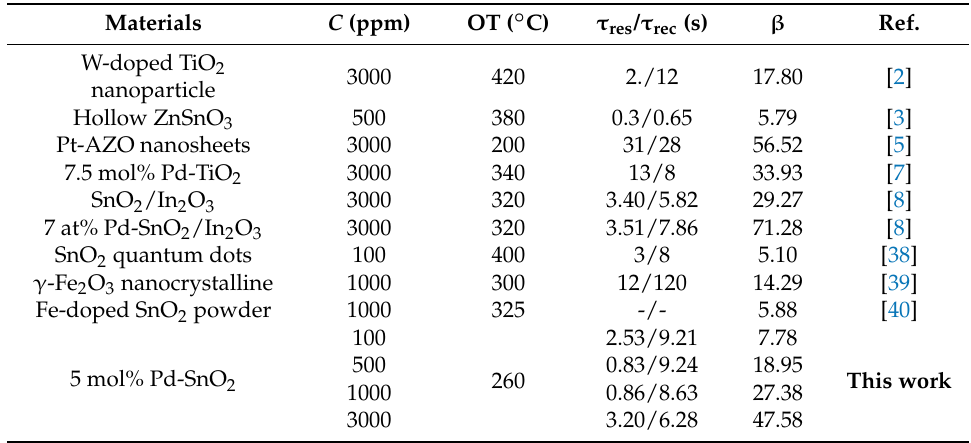
Table 1. Comparison of gas-sensing performances of sensors based on various nanostructural materials toward butane.